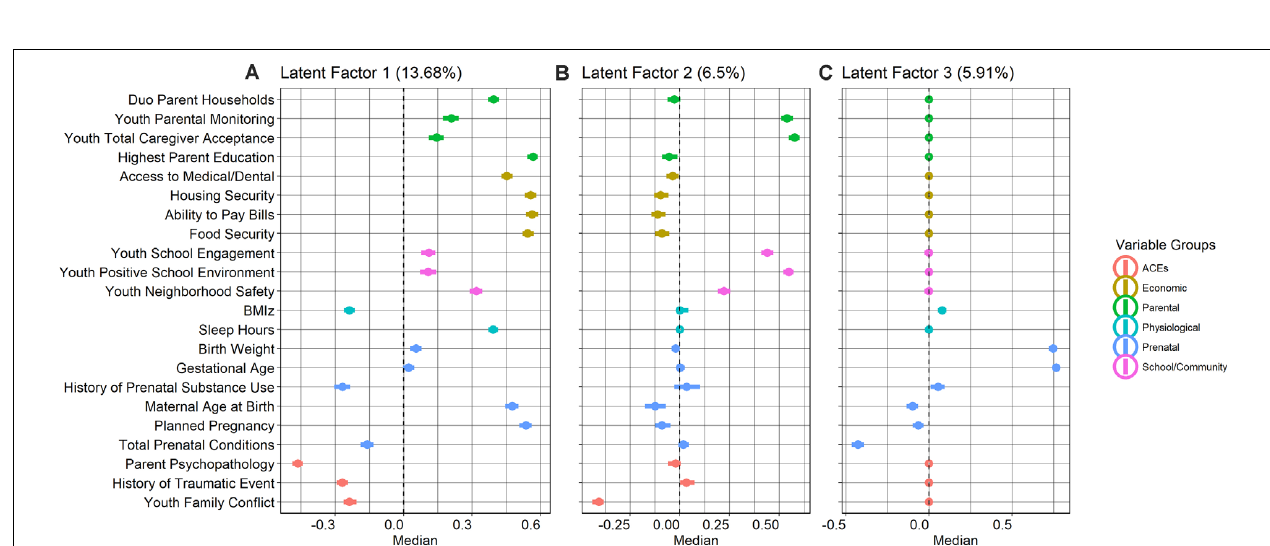
FIGURE 1 | Plots showing the non-linear relationship between socioeconomic status (SES) as measured by the INR (A) total cortical surface area and (B) total cognition scores. Increases in each developmental measure were steepest for children from lower SES households (near poverty and below, i.e., < 200% of the federal poverty level).